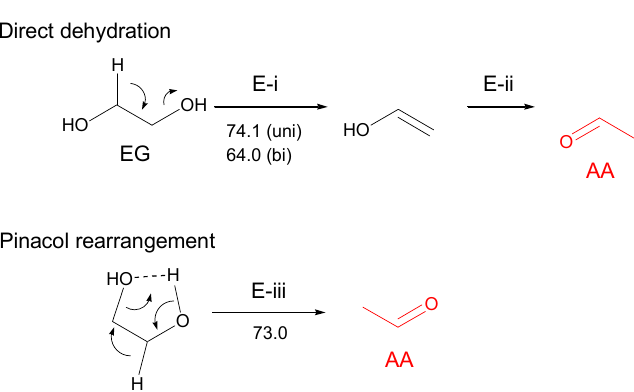
Figure 9. Possible heterolytic dehydration pathways for ethylene glycol (EG). The values next to the arrows represent the activation energies (kcal mol − 1 ), as calculated at the MP4(SDQ)//DFT(M06-2X) level. AA, acetaldehyde; uni, unimolecular mechanism; and bi, bimolecular mechanism (EG-EG).